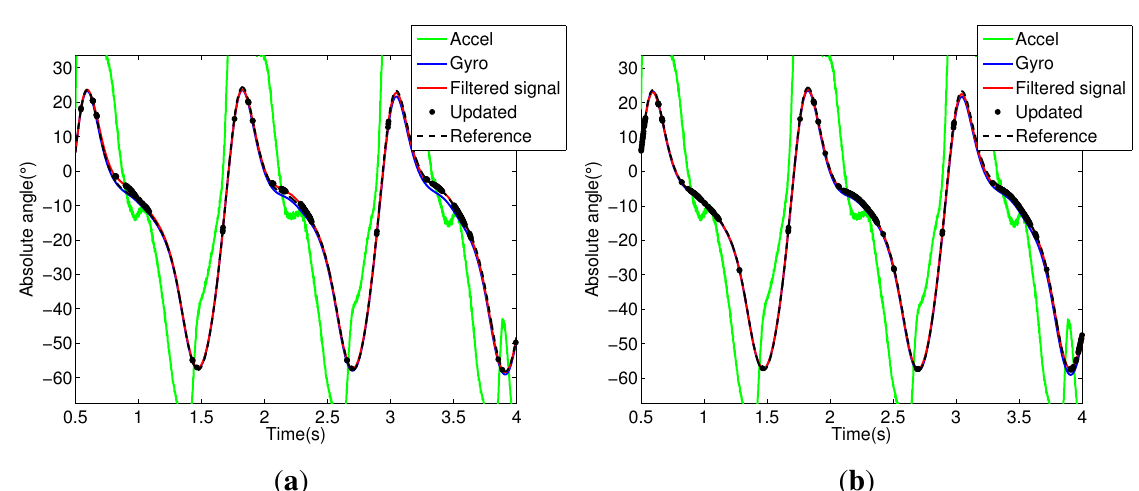
Figure 7. Shank segment. ( a ) KF signals; ( b ) MKF